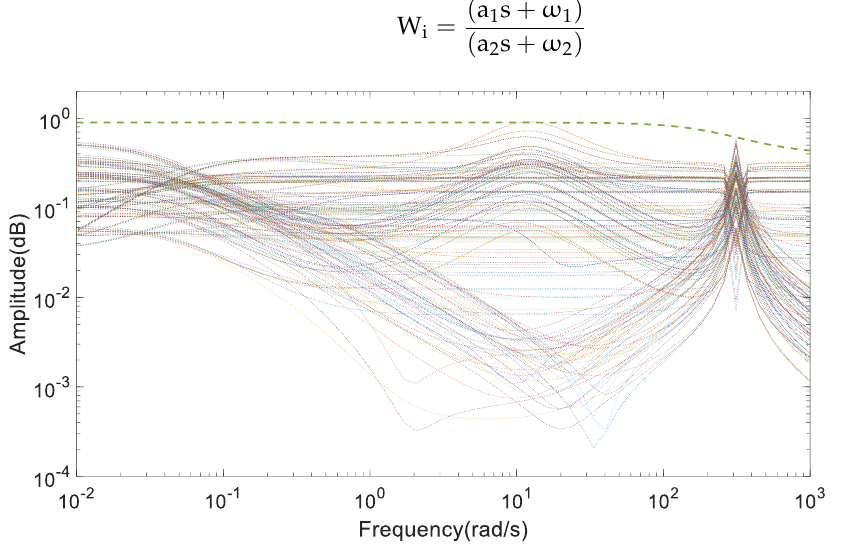
Figure 19. Maximum singular value set for uncertain systems.